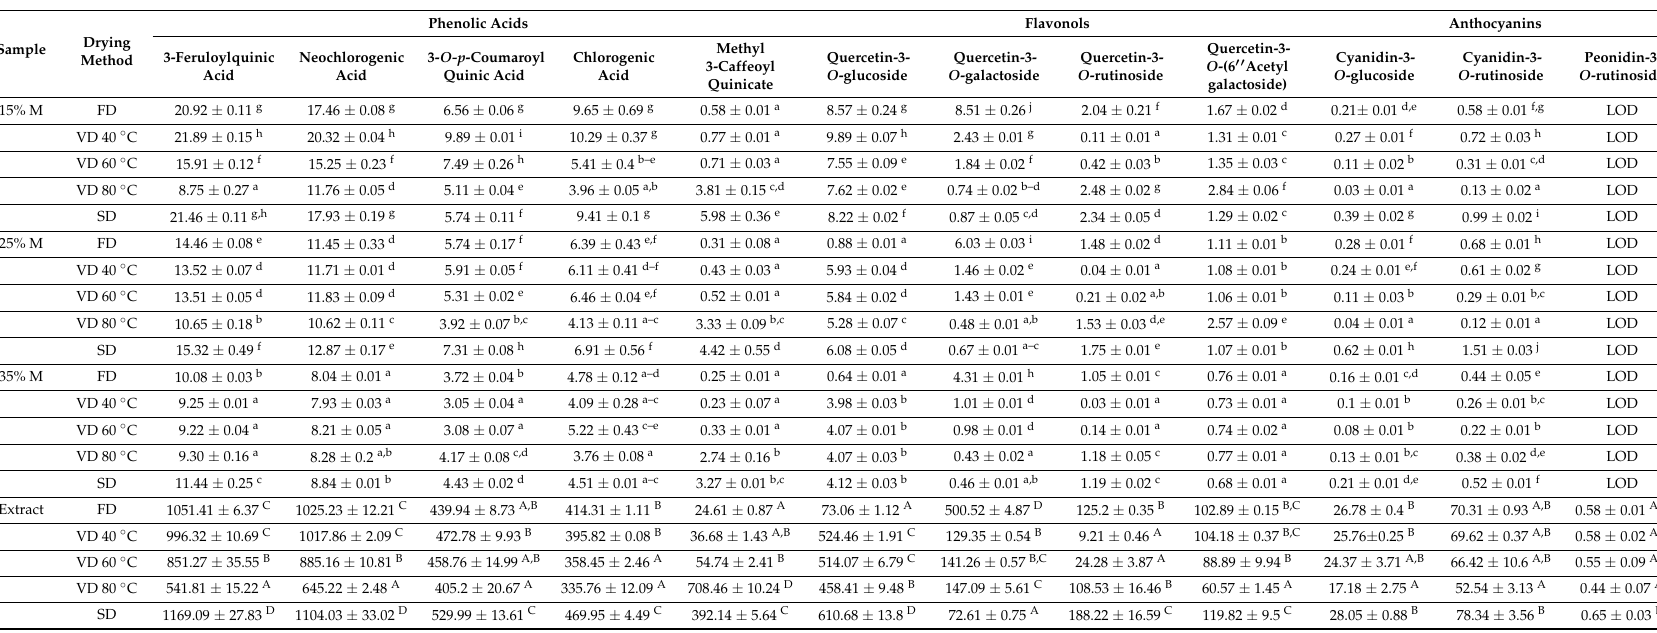
Table 2. The content of polyphenolic compounds present in plum juice powders obtained by freeze drying (FD), vacuum drying (VD), and spray drying (SD) (mg · kg − 1